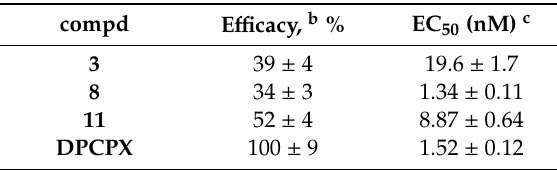
Table 2. Modulation of Forskolin-stimulated cAMP levels of selected amino-3,5-dicyanopyridine derivatives on cyclic cAMP assay in hA 1 CHO cells. a.